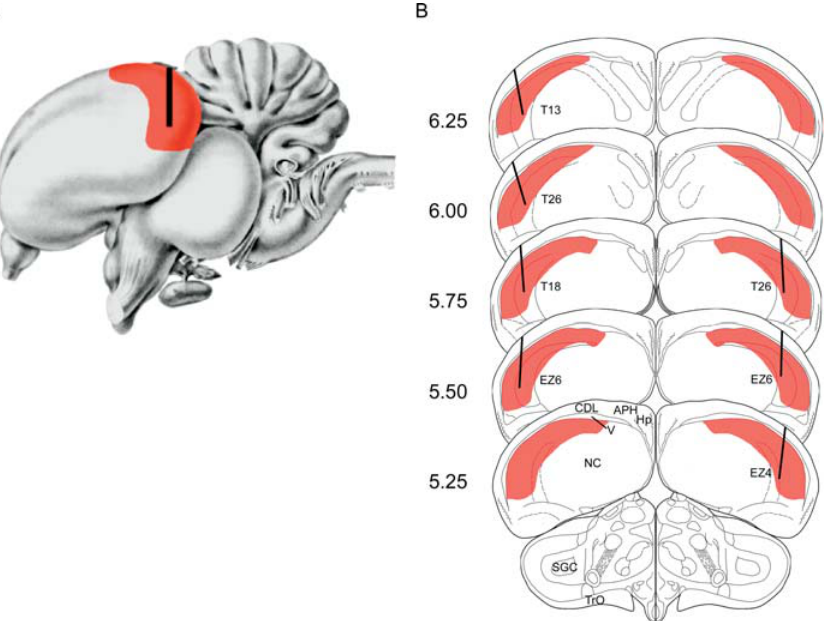
Figure 2. Histology (A) Lateral view of the pigeon brain. The NCL is shaded in red. The black line represents the intended electrode trajectory. (B) Histological reconstruction of the electrode tracks for the five pigeons. The NCL is shaded in red. The black lines represent the electrode track. All tracks were within the boundaries of the NCL. APH, area parahippocampalis; CDL, area corticoidea dorsolateralis; Hp, hippocampus; NC, nidopallium caudale; SGC, stratum griseum centrale; TrO: tractus opticus; V: ventricle. DOI: 10.1371/journal.pbio.0030190.g002